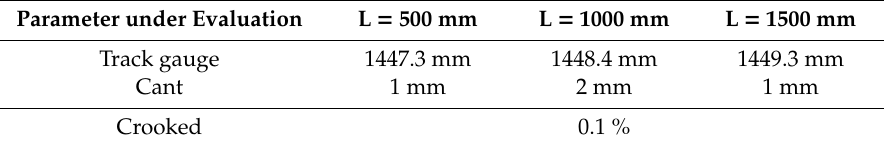
Table 2. Geometrical parameters of the track resulting from the inspection procedure.